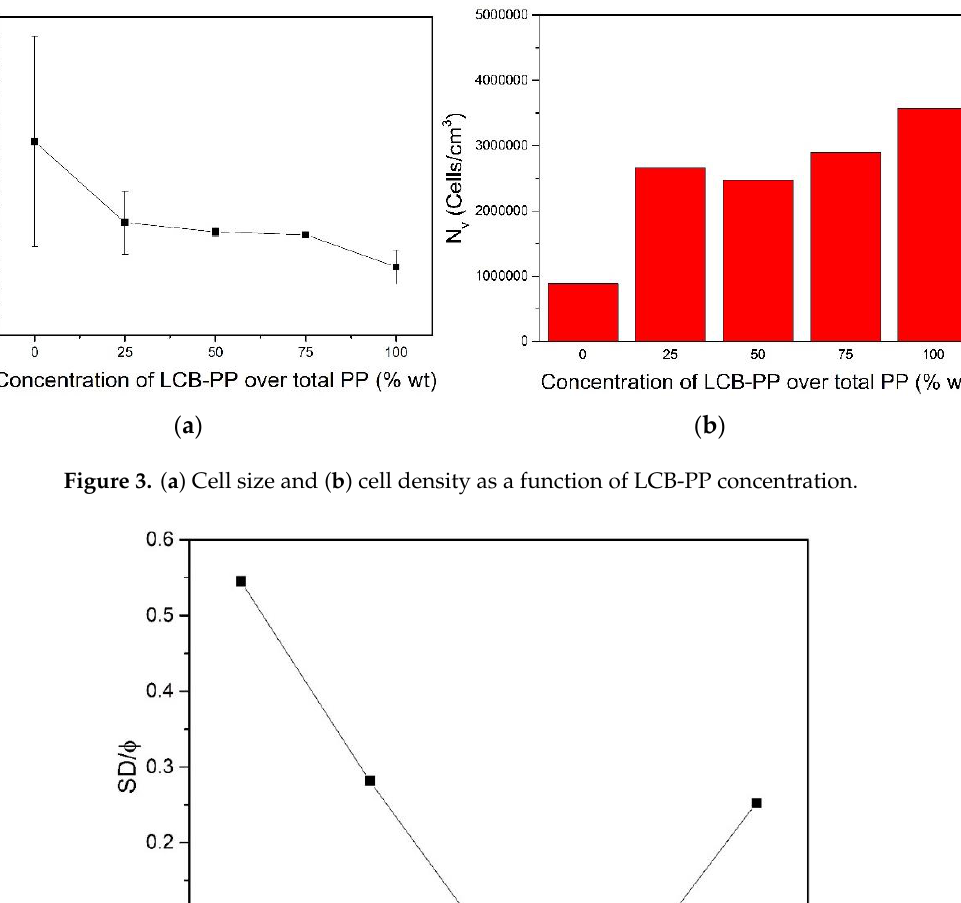
Figure 2. Scanning electron microscopy (SEM) micrographs of several obtained samples: ( a ) long-chain branched polypropylene (LCB-PP) 0% ( b ) LCB-PP 25% ( c ) LCB-PP 50% ( d ) LCB-PP 75% ( e ) LCB-PP 100%. The scale bar represents 200 μm.